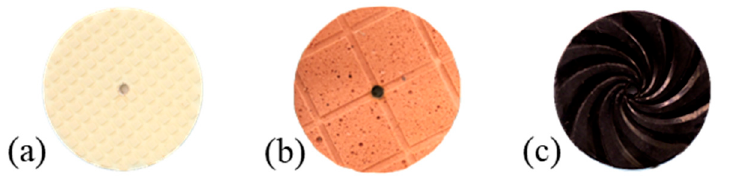
Figure 6. Three types of polishing tools. ( a ) Consolidated abrasive; ( b ) polyurethane; ( c ) asphalt.